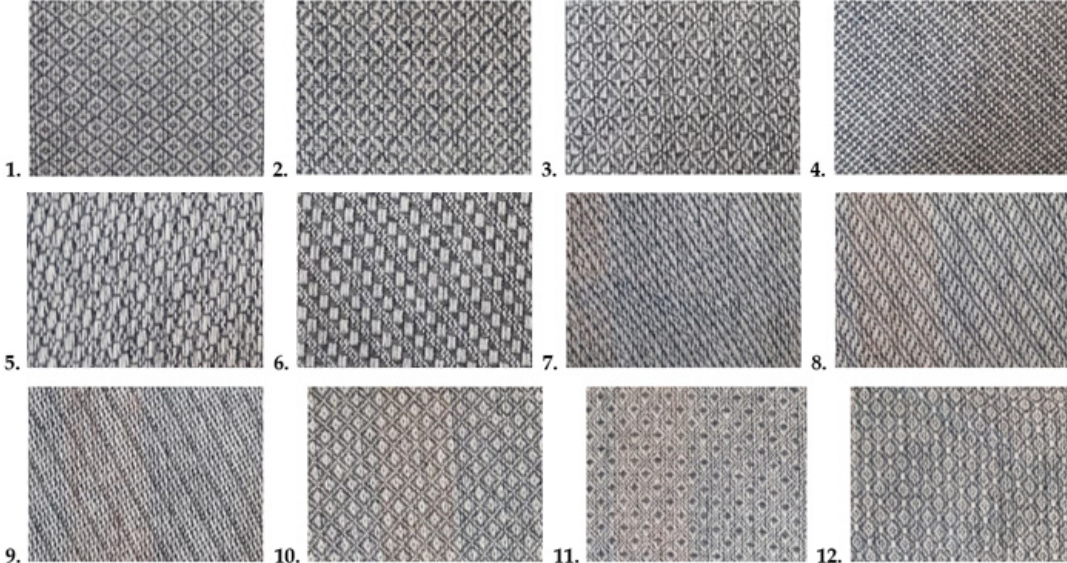
Figure 2 . Pictures of the woven fabrics: 1, 2, 3—diamond twills; 4, 5, 6—derived baskets; 7, 8, 9— derived twills; 10, 11,